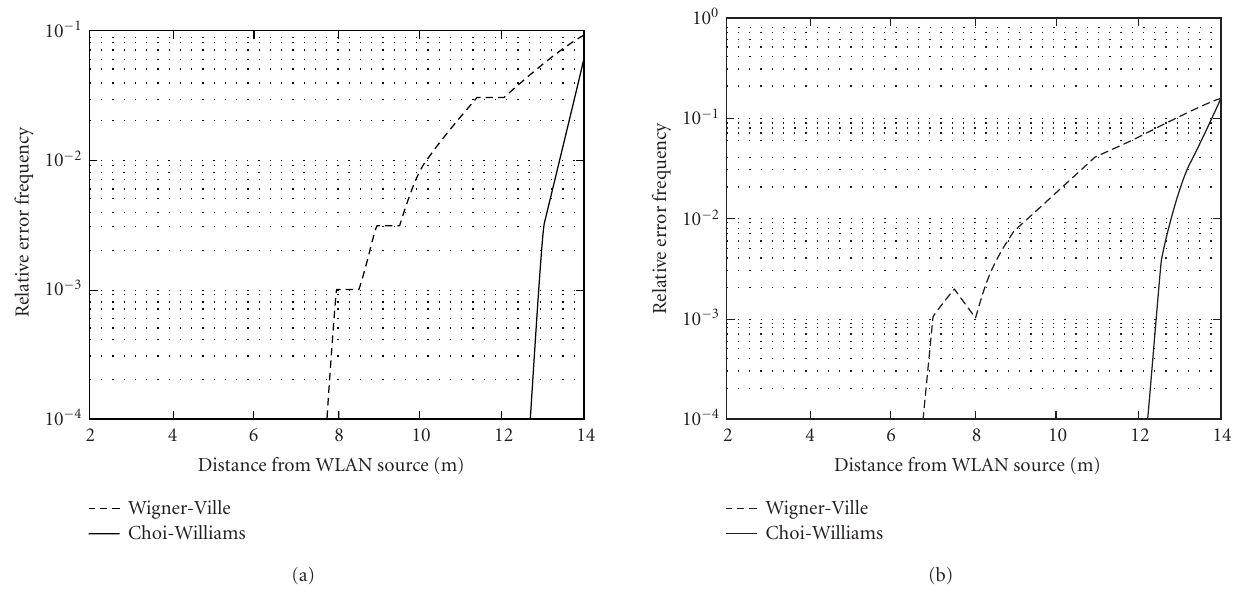
Figure 8: Relative error frequency of WLAN by using (a) the SVM and (b) the FFBPNN.